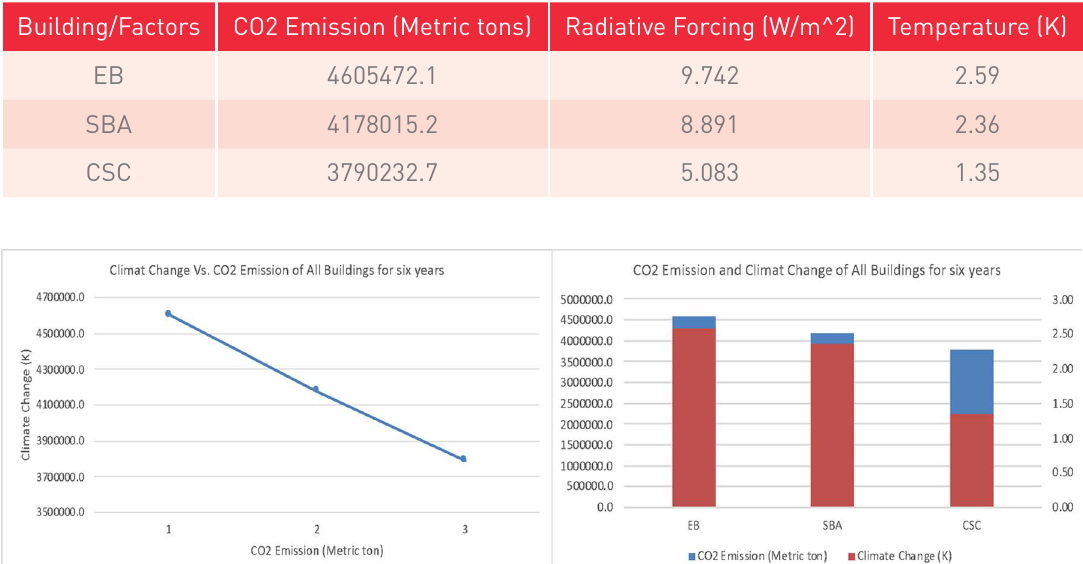
F and ∆ Ts of all three buildings ∆